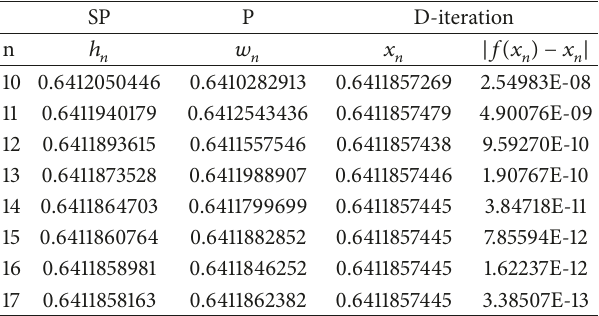
Table 3: SP-, P-, and D-iterations for 𝑓(𝑥) = cos (0.2𝑥 + 3) + 𝑥 . SP P D-iteration